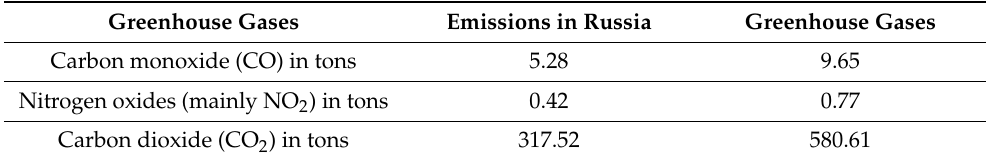
Table 4. Emissions in underground coal mines in Russia and Europe due to the combustion of methane extracted by early degasification (scenarios 2 and 3).